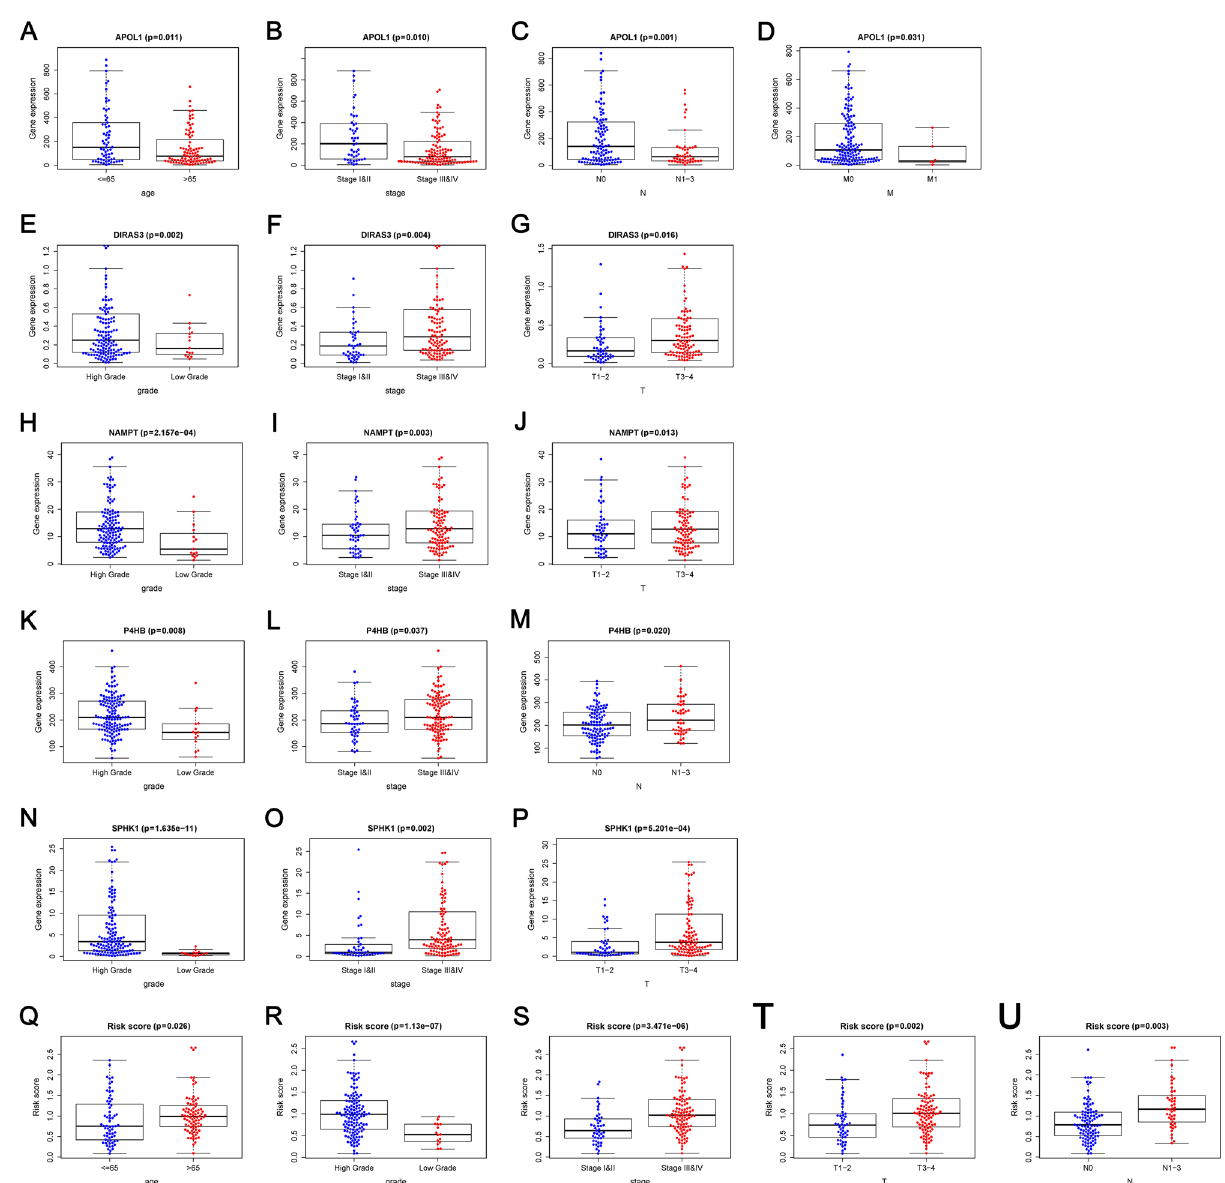
Figure 5. Relationship between prognostic model related factors and clinical variables. ( A – D ) APOL1 and clinical variables. ( E – G ) DIRAS3 and clinical variables. ( H – J ) NAMPT and clinical variables. ( K – M ) P4HB and clinical variables. ( N – P ) SPHK1 and clinical variables. ( Q – U ) Risk score and clinical variables. Box plots with P < 0.05 are